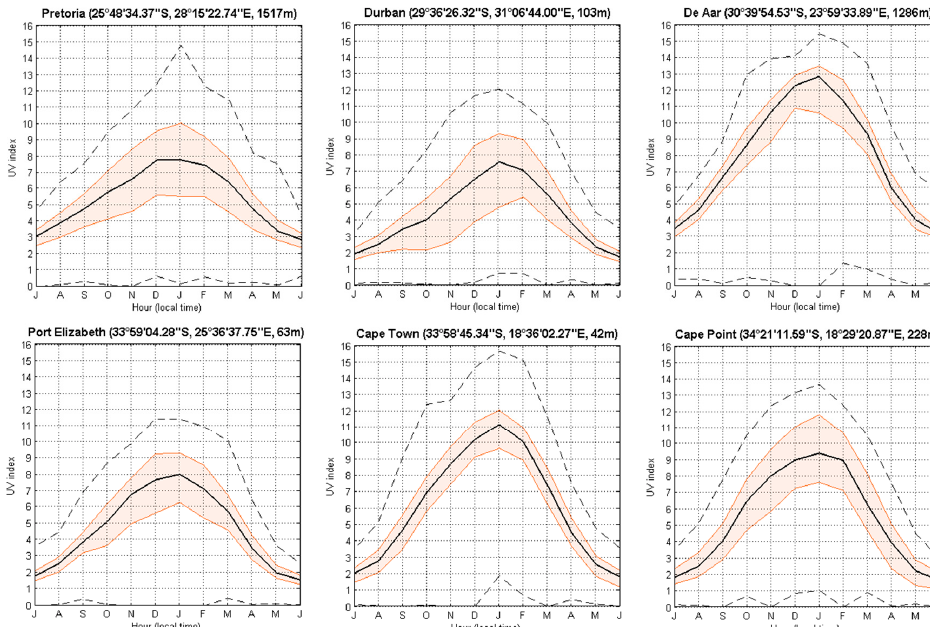
Figure 5. Monthly climatological median (black line) of the solar UVI for the six South African sites at satellite overpass time, for all years of observation (i.e., 1994–2015). Quantile 25 and 75 (filled orange lines) and minimum and maximum (black dash line) are also represented.